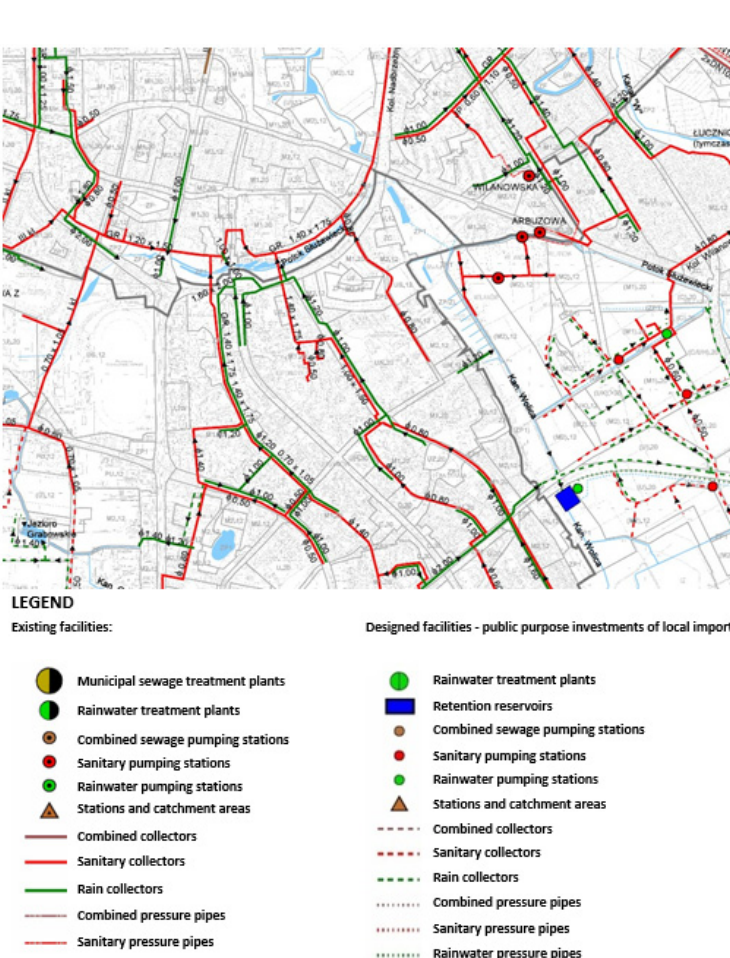
Figure A1. Sanitary, storm and combined sewer system for the catchment area of the S ł u ż ewiecki Stream and the Wolica Canal (the part covering the districts of Mokotów and Wilanów).